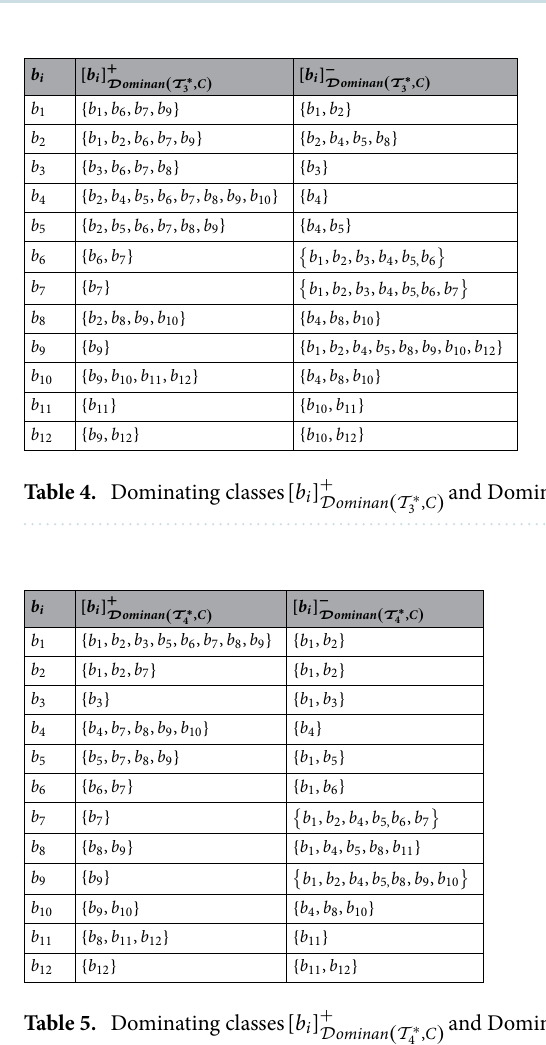
C ) and Dominated classes 4 ,